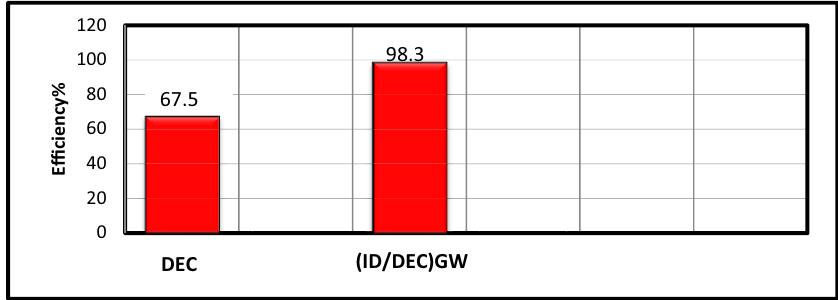
Figure 7: Compression between DE e ffi ciency and presented IDE e ffi ciency with geothermal water.